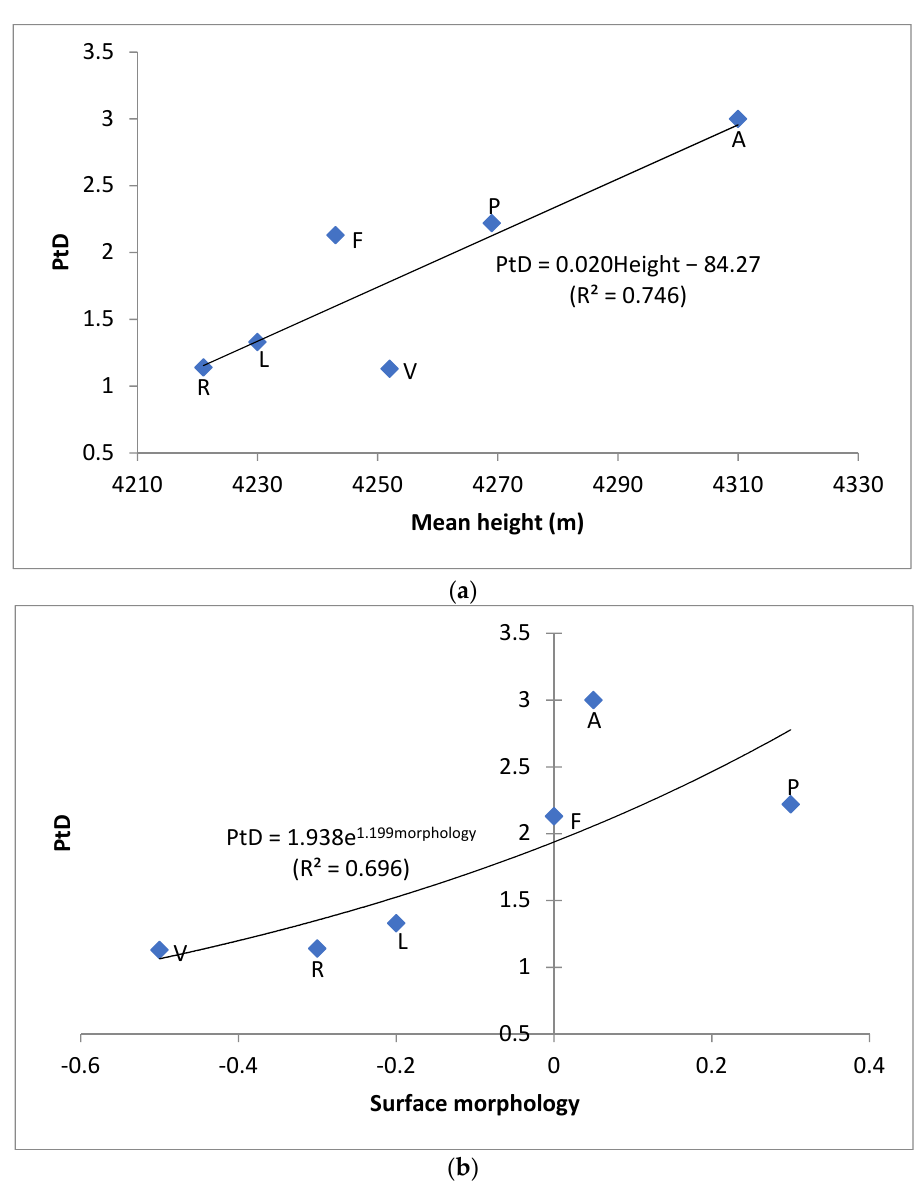
Figure 4. Regression relationship between propensity to degrade (PtD) and topographic features for six types of swampy meadows. ( a ) Mean height (m) above sea level; ( b ) surface morphology. If PtD is nonlinearly estimated from the weighted surface morphology, 69.6% of its variations can be accounted for by surface morphology (Equation (4)). This proportion is